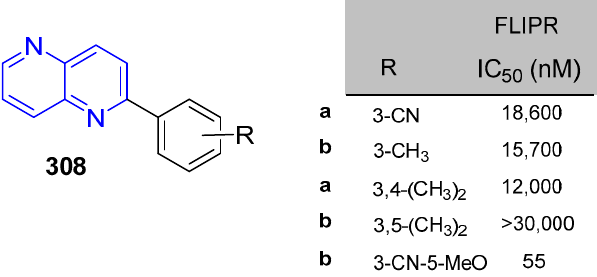
Figure 29. 1,5-Naphthyridine analogues as mGLuR5 antagonists. pIC 50 values measure by a fluorometric imaging plate reader assay (FLIPR).